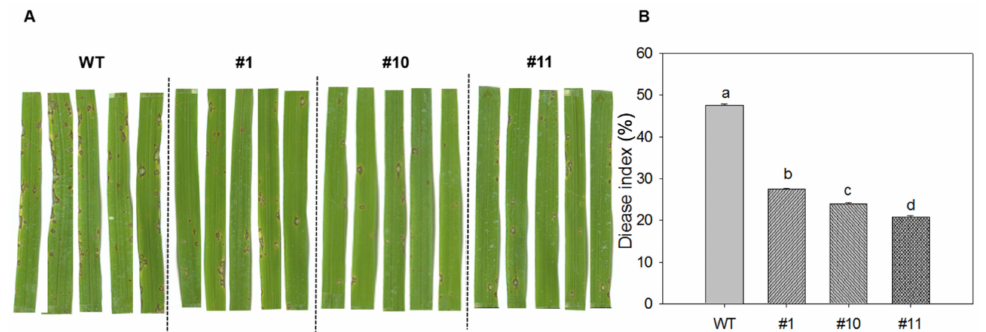
Figure 5. MoSDT1 overexpression confers improved rice blast resistance. ( A ) The symptom of rice blast resistance after 95234I-1b inoculation. ( B ) Disease index of rice blast resistance after 95234I-1b inoculation. Di ff erent letters represent statistically significant di ff erences ( p < 0.05).